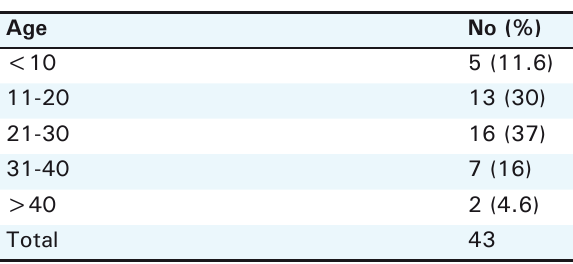
table 1. Age distribution